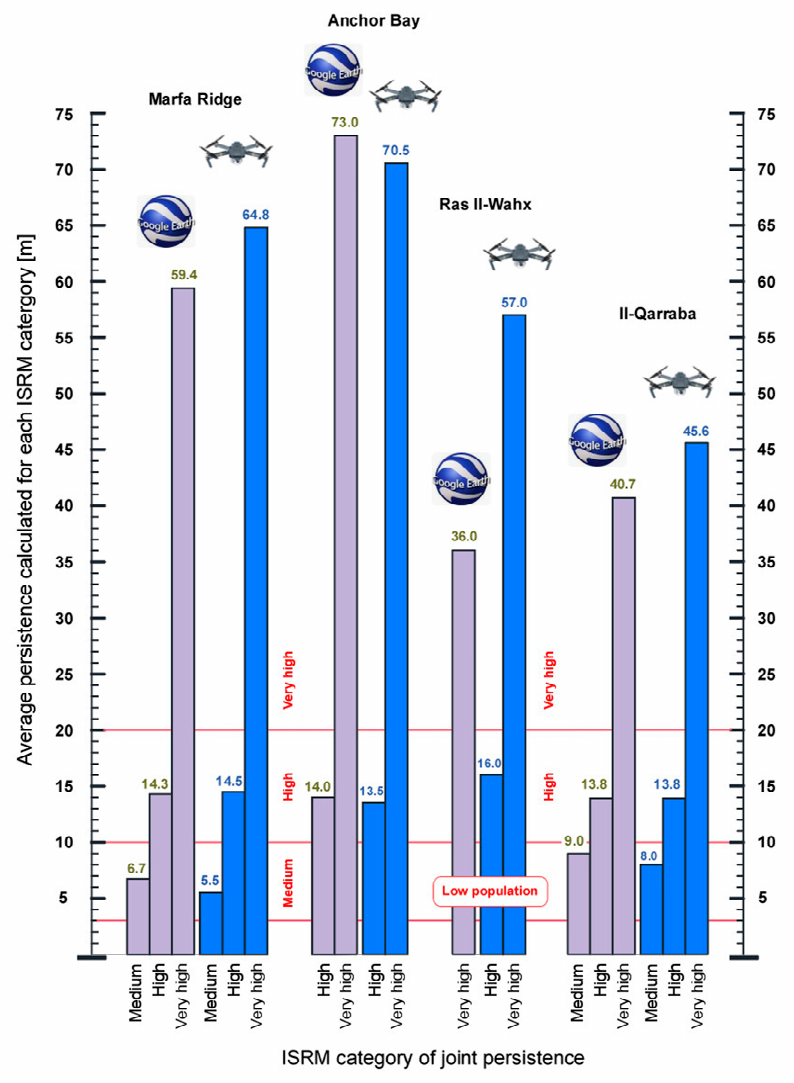
Figure 14. Averaged length per joint using GE-derived existing dataset and UAV-DP outputs. The persistence terms follow ISRM standards [76].